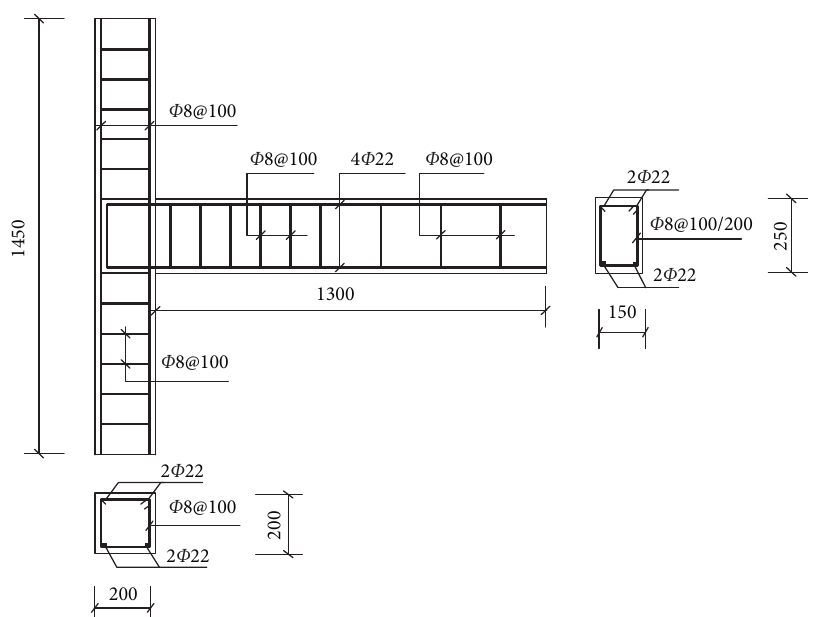
Figure 1: The sizes and reinforcements of the specimen (unit: mm).